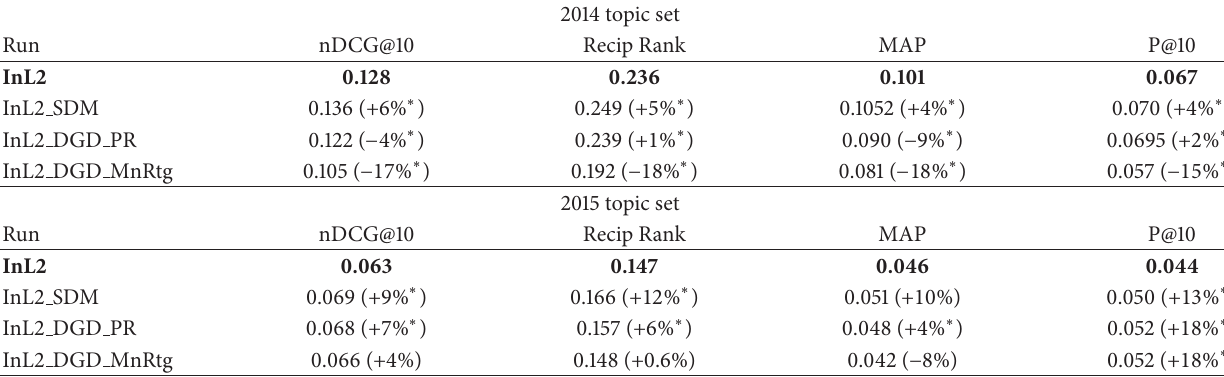
Table 2: Experimental results. The runs are ranked according to nDCG@10. ( ∗ ) denotes significance according to Wilcoxon test [8]. In all cases, all of our tests produced two-sided 𝑝 value, 𝛼 = 0.05